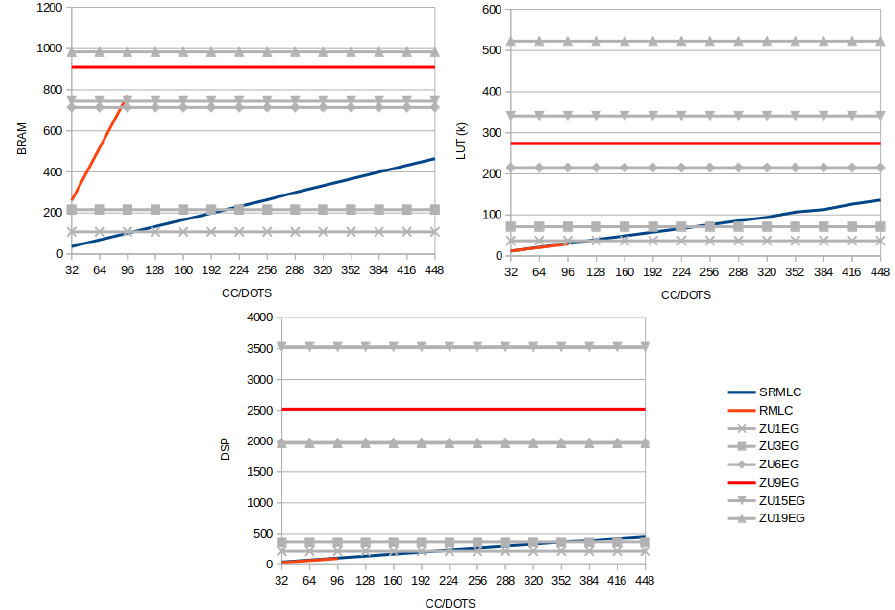
Figure 24. Resource scaling for the